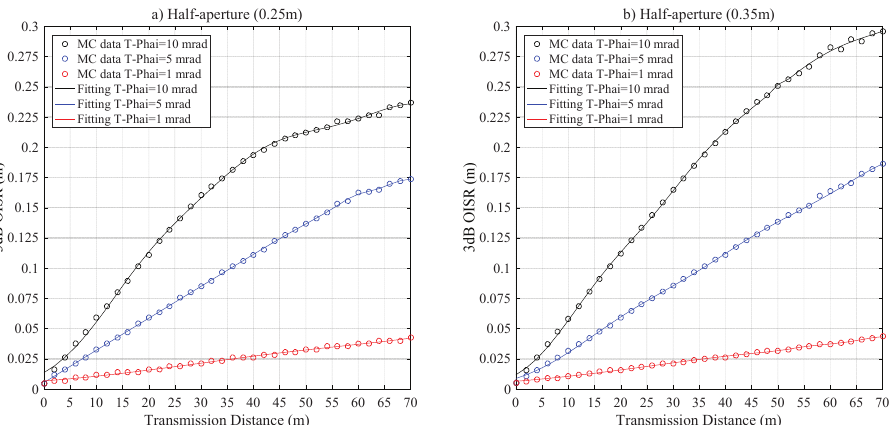
Figure 8. The r 3 dB versus Z 0 for the clean seawater laser channel for a half-aperture of ( a ) R PD = 0.25 m and ( b ) R PD = 0.35